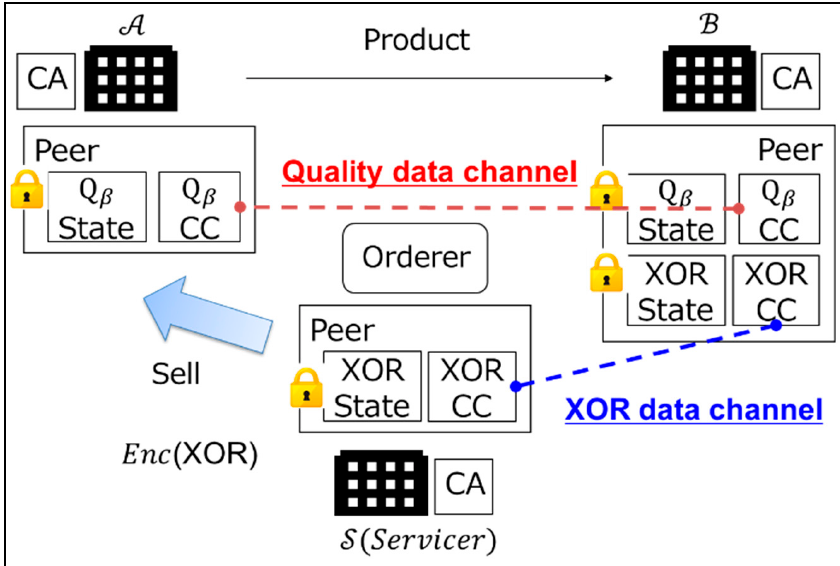
Figure 3. Proposed B2B collaboration system.